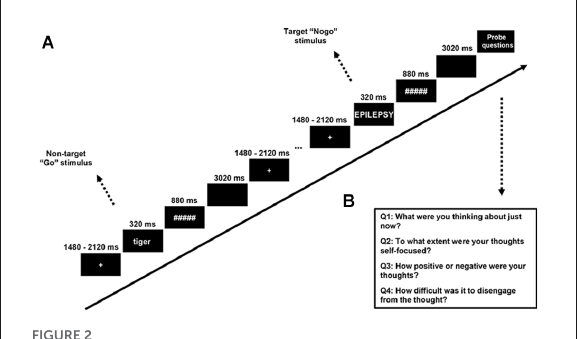
FIGURE2 (A) Stimuli and procedure of the SART—all stimuli were flickering with a frequency of 12.5 Hz. A fixation cross was present firstly for a variable duration (sampling from 1,480, 1,640, 1,800, 1,960, or 2,120 ms). Word stimuli were presented for 320 ms and a mask presented for 880 ms followed. A trial ended with a 3,020-ms blank screen. (B) Thought probe